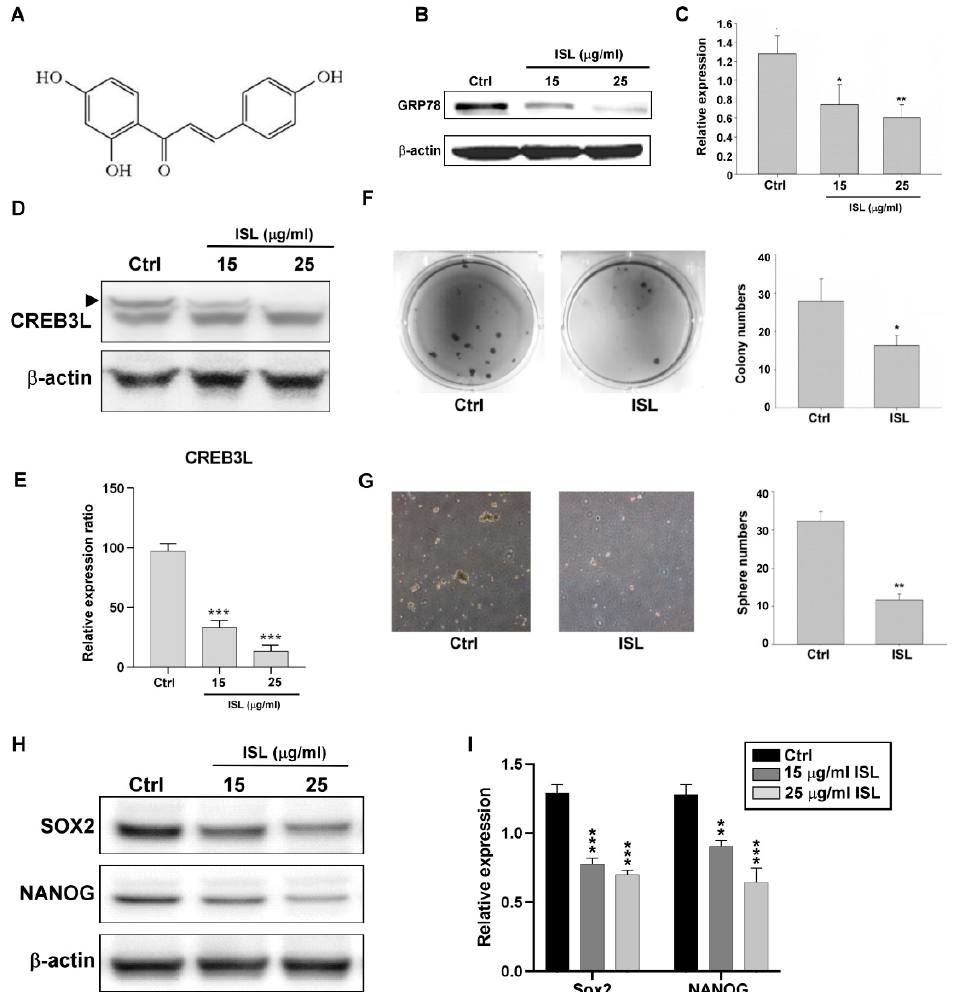
Figure 4. The stemness characteristic was reduced by isoliquiritigenin (ISL) treatment. ( A ) Structural formula of ISL. ( B ) Glucose-regulated protein 78 (GRP78) expression in MKN45 cells was inhibited after treatment with 15 or 25 μ g/mL ISL for 72 h. ( C ) Quantification of GRP78 expression after ISL treatment. ( D ) The protein expression of the transcription factor CREB3L1 was downregulated in MKN45 cells after treatment with 15 or 25 μ g/mL ISL for 72 h. ( E ) Quantification of CREB3L1. ( F ) Representative pictures demonstrating that the colony-forming MKN45 cells were decreased after treatment with 25 μ g/mL ISL. ( G ) Representative pictures demonstrating that the spheroid body- forming MKN45 cells were decreased after treatment with 25 μ g/mL ISL. ( H , I ) The protein expres- sion of stemness-related transcription factors (SOX2 and Nanog) was downregulated in MKN45 cells after treatment with 15 or 25 μ g/mL ISL for 72 h. Data are presented as the mean ± standard error of mean; n ≥ 3 independent experiments, two-tailed Student’s t test: * p < 0.05, ** p < 0.01, *** p < 0.005.